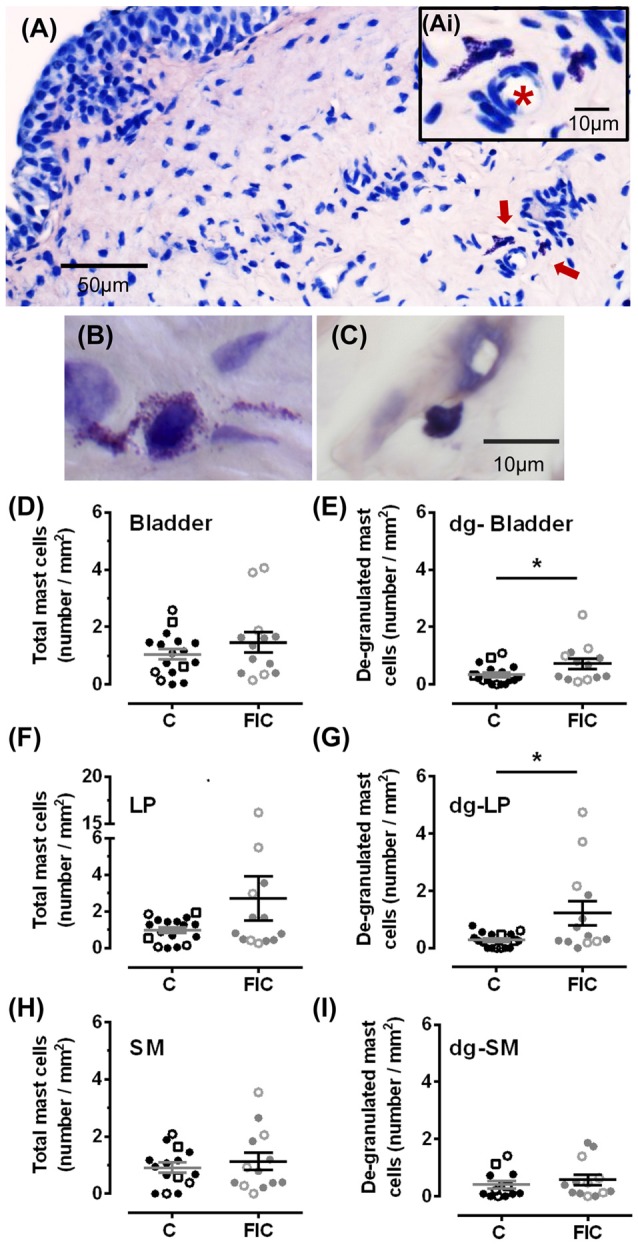
Mast cell quantification in bladder tissue from control and FIC cats. (A) Example of de-granulated mast cells, (red arrows) from a FIC cat. (Ai) Inset shows higher magnification of the area indicated by the red arrows and illustrates the presence of de-granulated mast cells in the vicinity of a blood vessel (red star placed in the lumen of the blood vessel). (B,C) Examples of de-granulated (B) and not de-granulated (C) mast cells from an FIC cat. (D–I) Quantification of mast cells and de-granulated (dg-) mast cells in bladder tissue from control (n = 17; individual data points shown in black, and average ± SEM in gray) and FIC (n = 13; individual data points shown in gray, and average ± SEM in black) cats. Statistical significance was tested using Mann-Whitney test. Asterisk (*) indicates p < 0.05. (D) Total number of mast cells, including granulated and de-granulated, in bladder tissue which is comprised of lamina propria (LP) and smooth muscle (SM) in control and FIC tissue (p = 0.50). (E) Total number of de-granulated mast cells in the bladder in control and FIC tissue (p = 0.037). (F) Total number of mast cells in the LP in control and FIC tissue (p = 0.38). (G) Total number of de-granulated mast cells in the LP in control and FIC tissue (p = 0.01). (H) Total number of mast cells in the SM in control and FIC tissue (p = 0.90). (I) Total number of de-granulated mast cells in the SM in control and FIC tissue (p = 0.47). In all panels, each symbol represents data from one animal. Open circles represent males, closed circles females and open squares represent undocumented sex. In (C), the highest data point is from a male FIC cat 48 months old that fit the criteria to be included in the study.